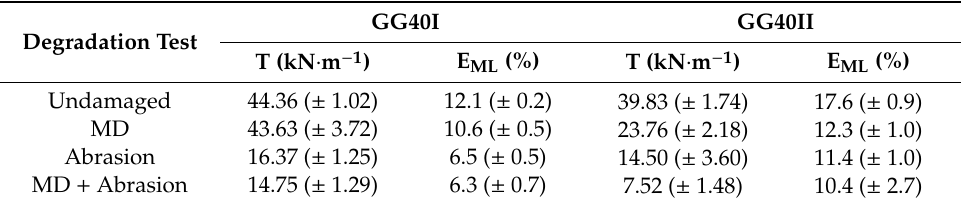
Table 4. Tensile properties of the woven geogrids GG40I and